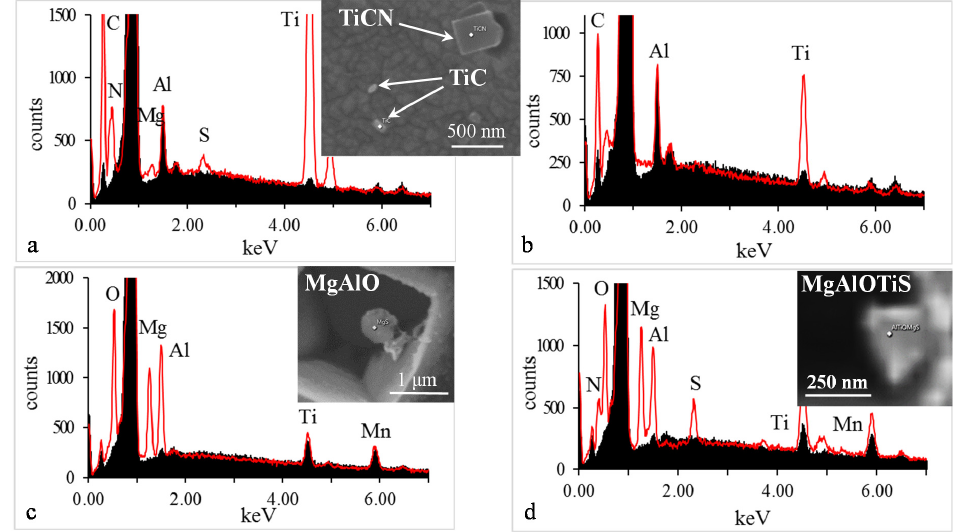
Figure 6. EDS spectra showing the chemical composition of ( a ) TiC and ( b ) TiCN particles in Monel K500 aged at 610 ◦ C and ( c ) MgSAlO and ( d ) AlTiOMgS in FM60 aged at 610 ◦ C (the travel speed of 500 mm/min). The matrix spectrum is shown in black; the particle spectrum is shown in